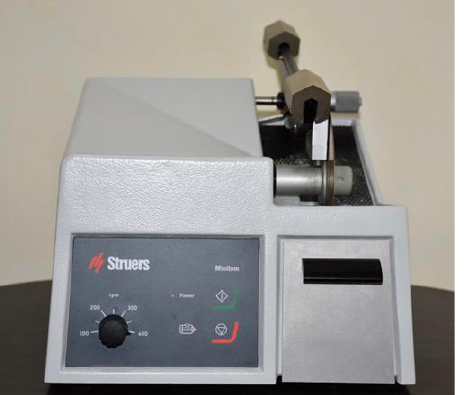
Figure 1: Minitome, Struers, Copenhagen, Denmark. Multiple group comparisons were performed using the nonparametric Kruskal-Wallis test. The P value between different test groups was Bonferroni correction. P value of less than 0.05 indicated a significant difference.